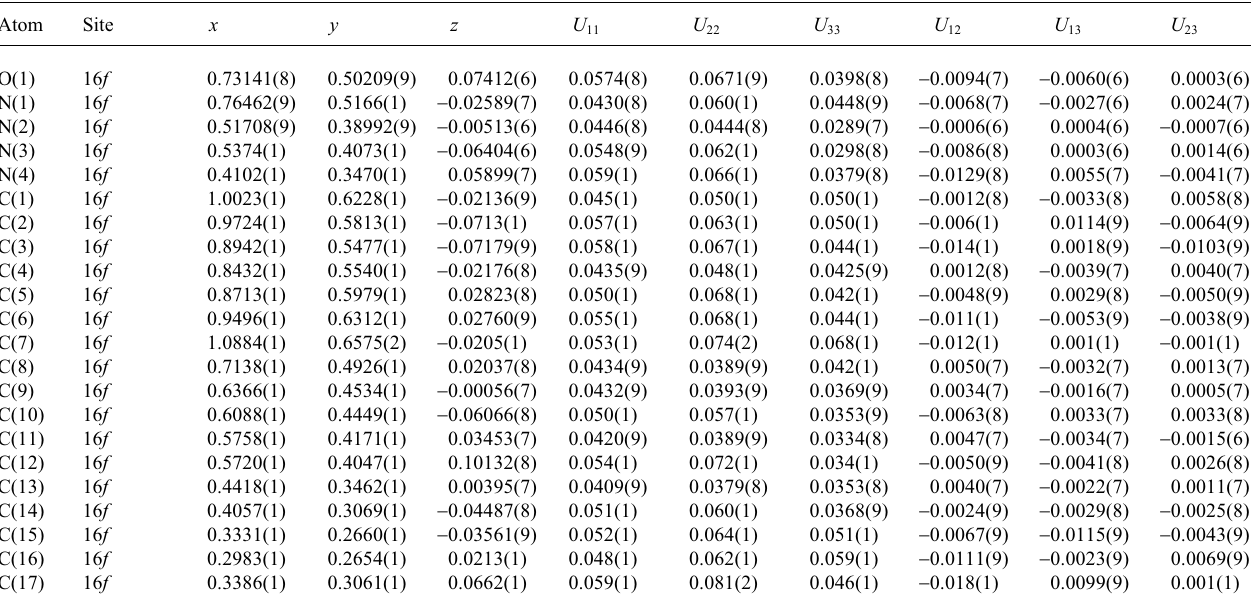
Table 3. Atomic coordinates and displacement parameters (in Å 2 )